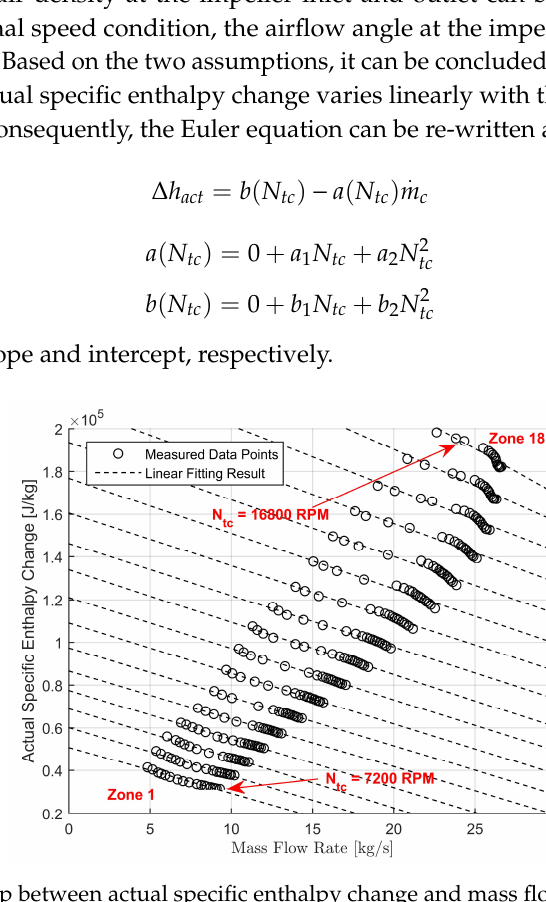
Figure 6. Relationship between actual specific enthalpy change and mass flow rate at each rotational speed condition (interval between each iso-speed curve is 600 RPM).